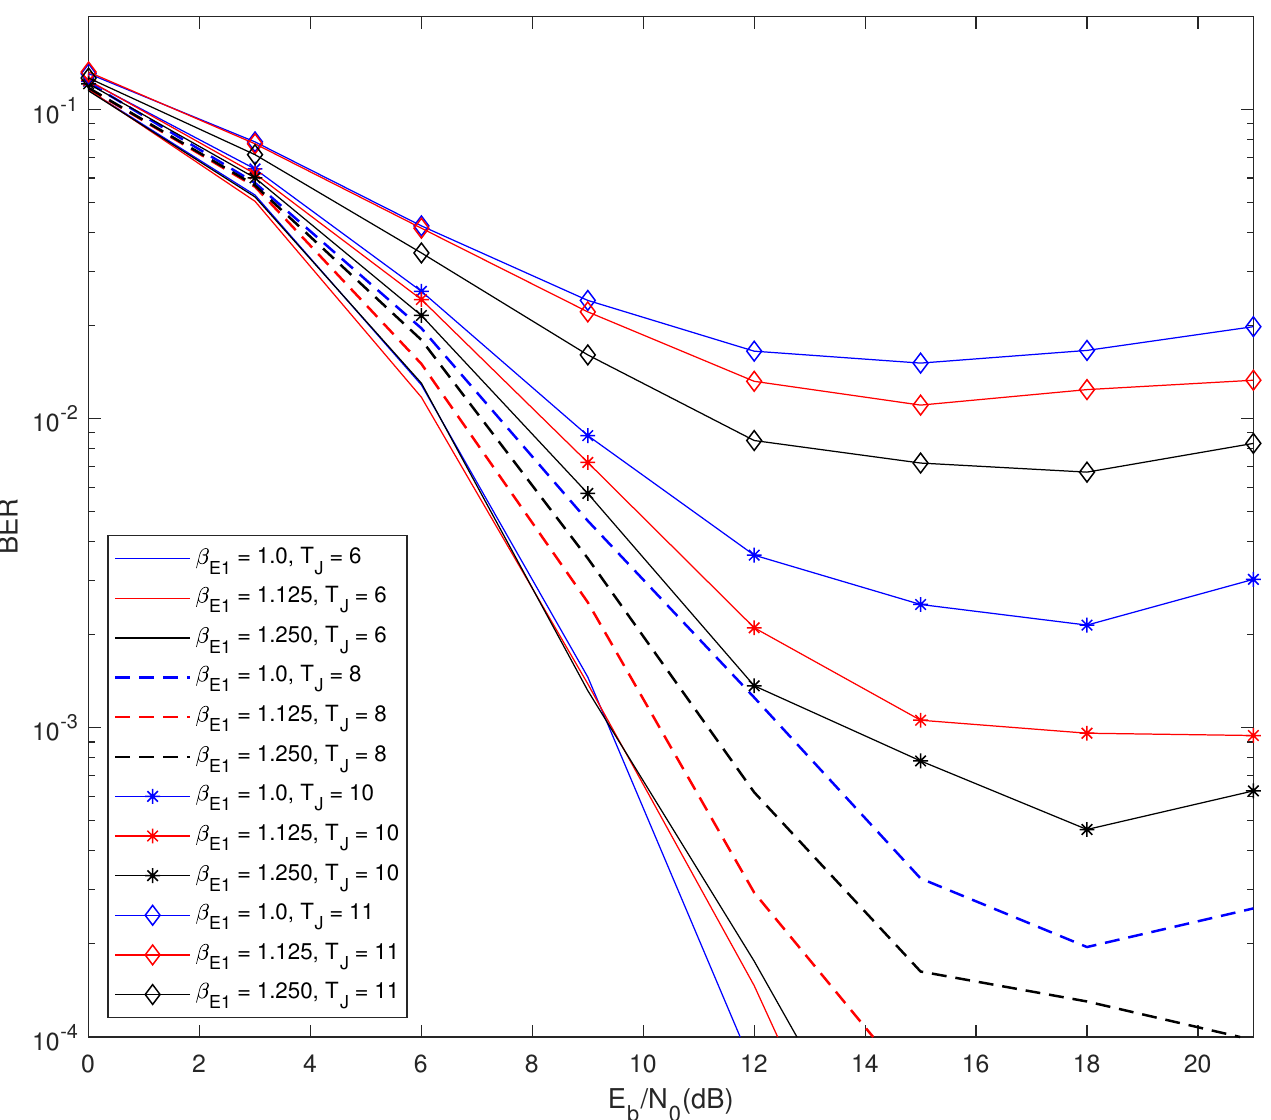
Figure 6. The BER results of E1 with the feedback of jamming signal estimate, where T J = R E 2